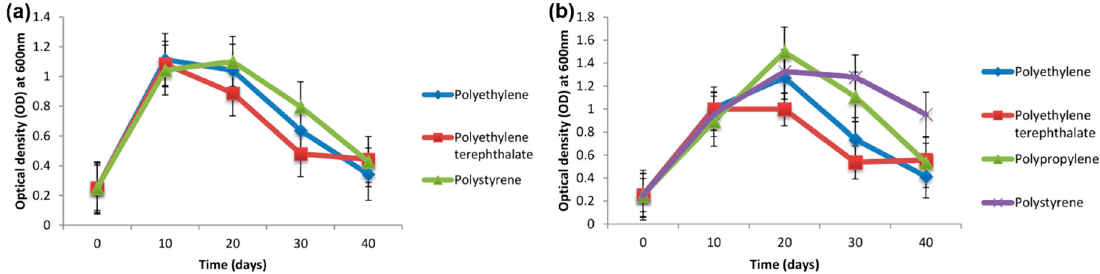
Figure 2. Growth curves of ( a ) Bacillus cereus and ( b ) Bacillus gottheilii used for microplastic biodegradation [10]. (Reprinted with permission from [10]. Copyright 2017 Elsev.).